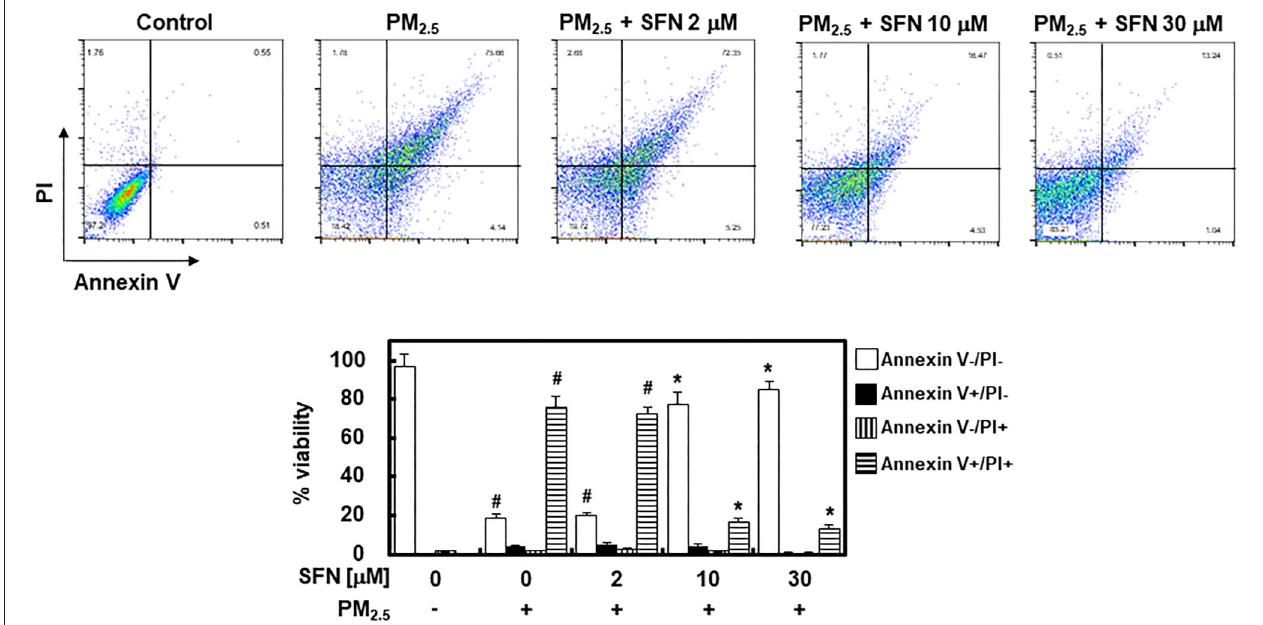
FIGURE 2 | Effects of Sulforaphane (SFN) on PM 2.5 -induced apoptosis in ARPE-19 cells. ARPE-19 cells were treated with PM 2.5 (100 µ g/mL) for 24h and subsequently treated with the specified concentrations of SFN (0–30 µ M) for 6h. Apoptosis was measured by Annexin V flow cytometry analysis. Values represent the mean ± SD of three independent experiments. * p < 0.01 relative to PM-challenged group, one-way ANOVA. # p < 0.01 relative to control, one-way ANOVA.